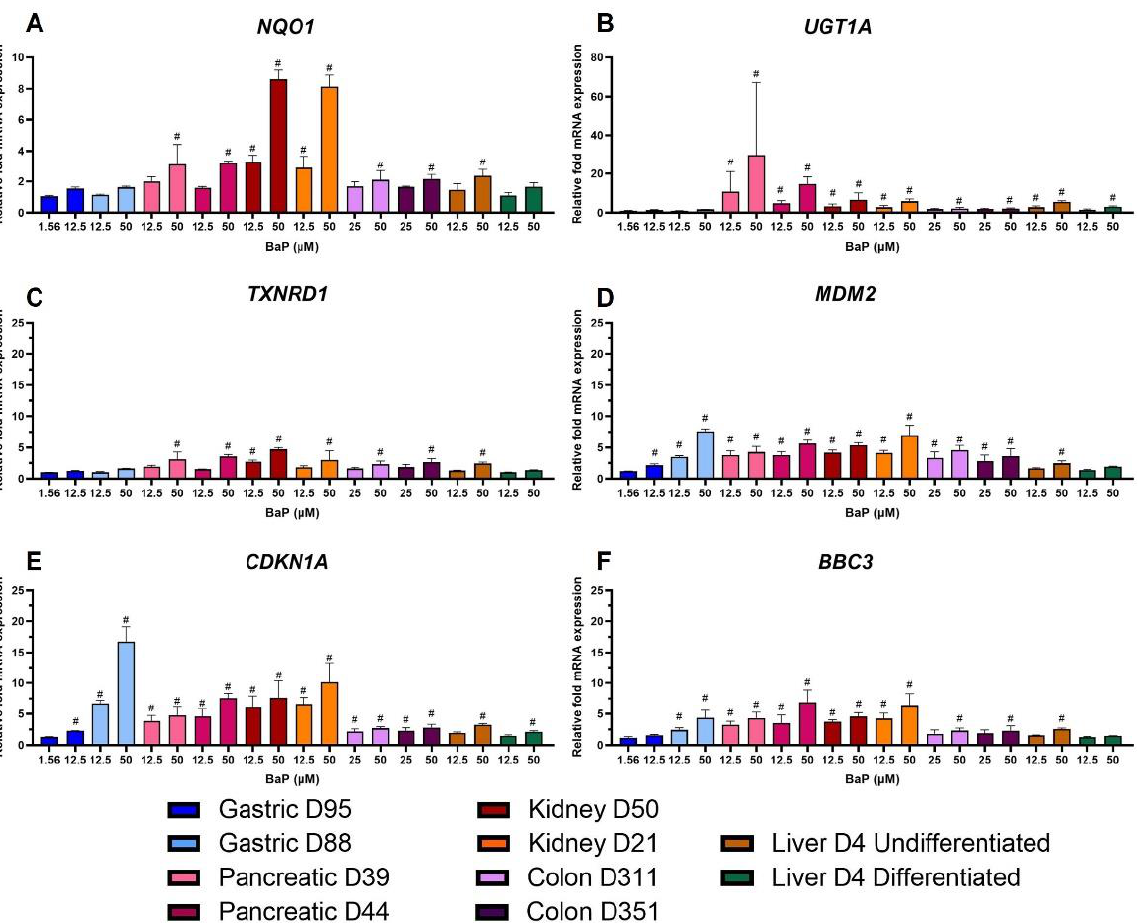
Figure 5. Effects of BaP on gene expression related to xenobiotic metabolism, oxidative stress response, transcription, proliferation and cell cycle control, and apoptosis. Human tissue organoids were treated with the indicated BaP concentrations for 48 h. Gene expression changes were measured by HT RT-qPCR. Linear fold-changes for ( A ) NQO1, ( B ) UGT1A, ( C ) TXNRD1, ( D ) MDM2, ( E ) CDKN1A and ( F ) BBC3 are shown as mean ± SD (n = 3). Log2 values ± 1 were considered biologically relevant (#), compared to the vehicle control (0.5% DMSO).